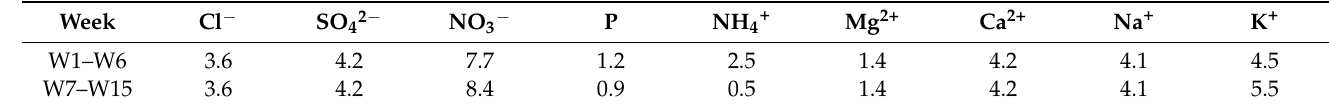
Table 1. Chemical composition (mmol/L) of the nutrient solution provided in heat treatments T24, T28, and T32. Differentiating between the first 6 weeks of culture (W1–W6) and from week 7 to the end